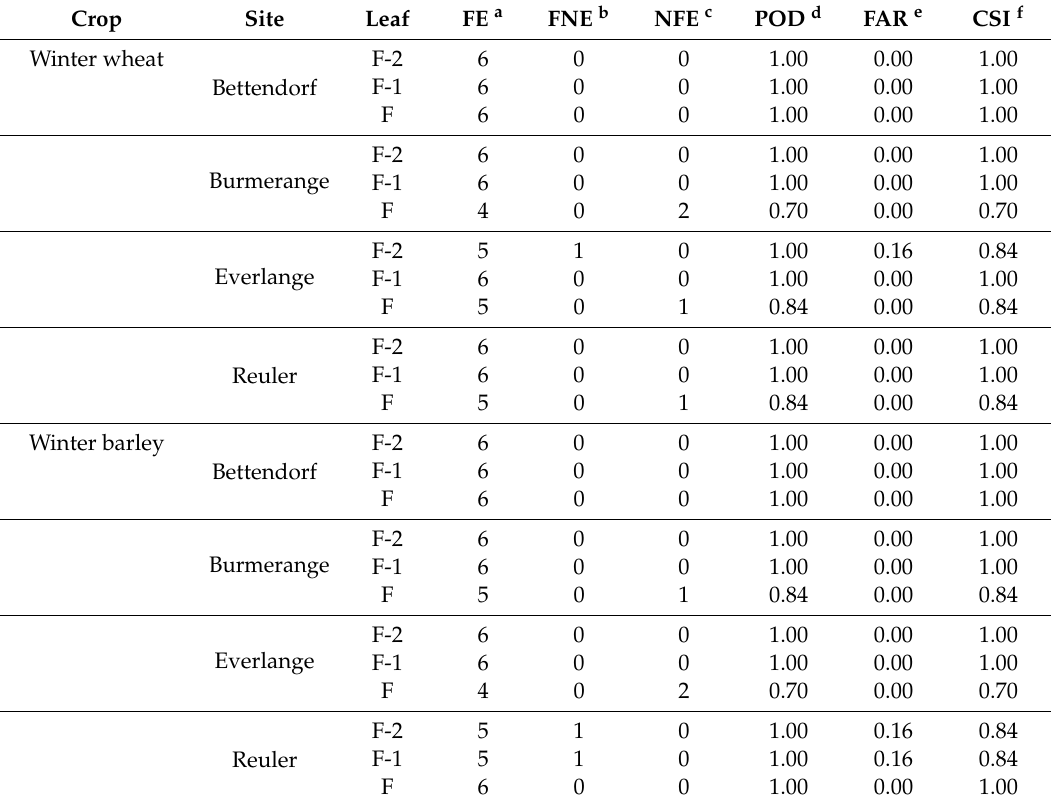
Table 3. Probability of detecting (POD) leaf emergence, false alarm ratio (FAR), and critical success index (CSI) using a phyllotherm of 100 ◦ Cd for winter wheat and winter barley during the 2014–2019 cropping seasons. The values of the forecasted and observed data used for the calculations of the statistical scores are provided. For 2017, 2018 and 2019, only observations for the wheat cultivar Kerubino were used. F = the flag leaf. Crop Site Leaf FE a FNE b NFE c CSI